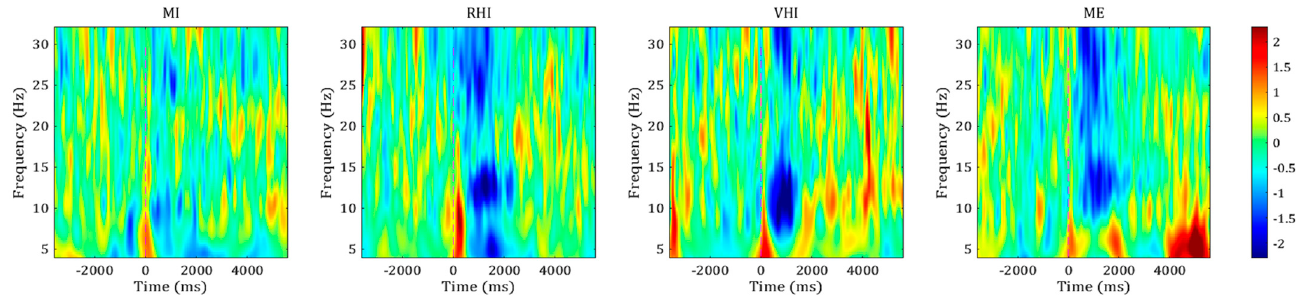
Figure 3. Averaged event-related spectral perturbation (ERSP) maps of each paradigm. The red dotted lines indicate task onset.